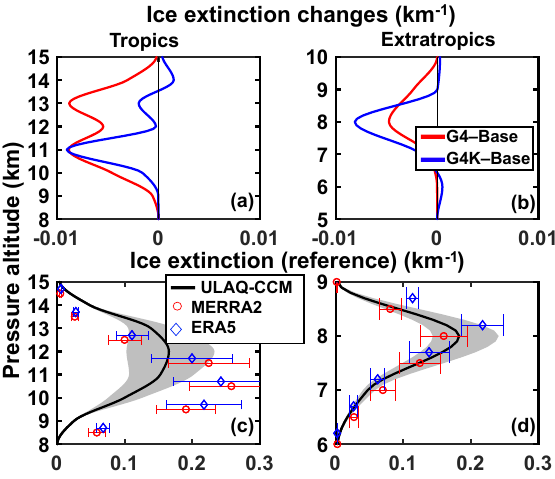
Ice extinction (reference) (km ) -1